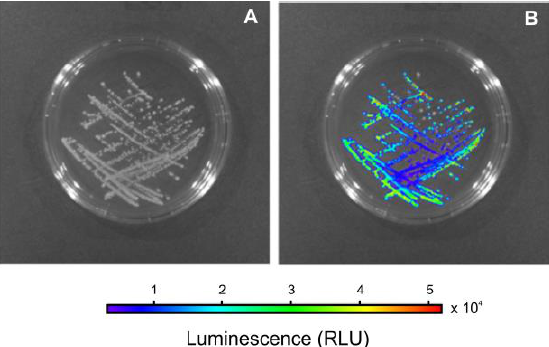
Figure 2. The black and white photo ( A ) and the resultant bioluminescence ( B ) of the successfully transformed P. aeruginosa strain with Addgene plasmid #14080. Acquired using IVIS Spectrum (Caliper/Perkin Elmer, Akron, OH, USA).